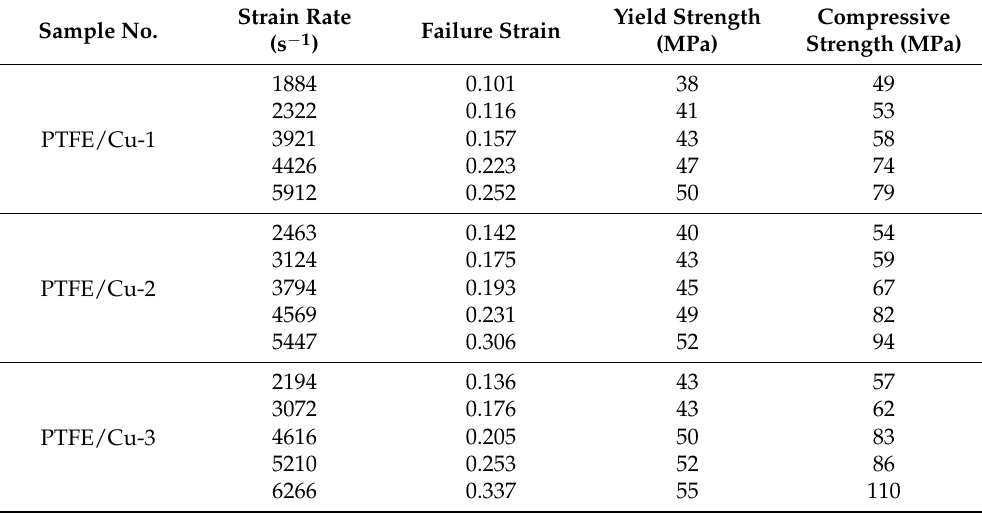
Table 2. Mechanical parameters of PTFE/Cu composites at different strain rates. Sample